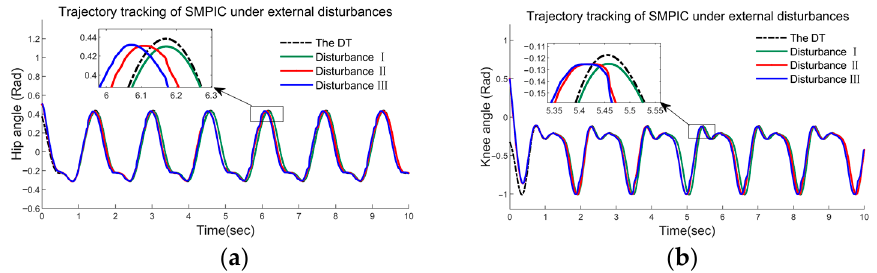
Figure 16. The tracking response of SMPIC of the joints under Case III. ( a ) the response of θ 1 and ( b ) the response of θ 2 under the disturbances with different magnitudes.